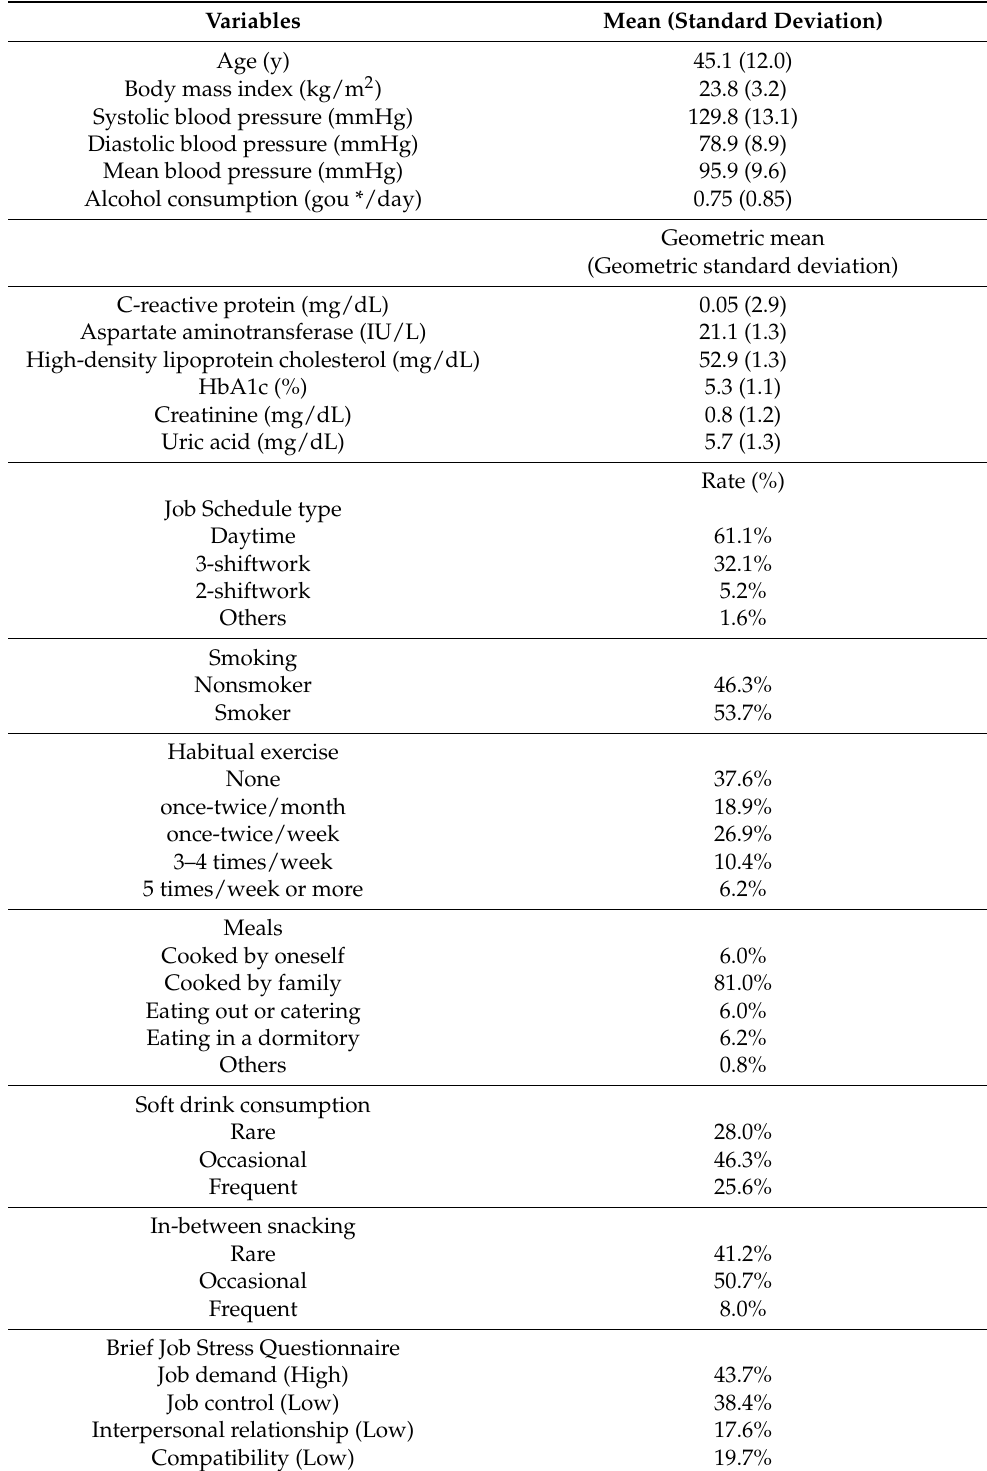
Table 2 indicates the number of person-years and incidence rate. The number of subjects who developed liver damage was 800, and the incidence per 1000 person-years was